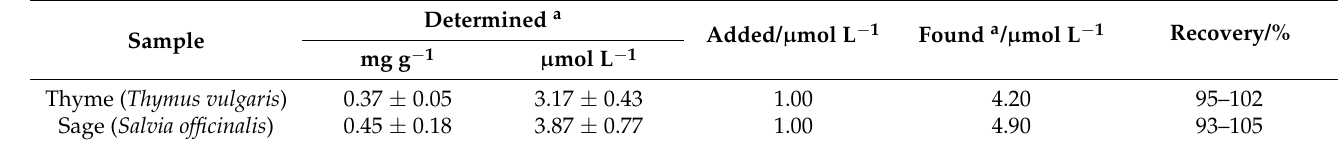
Table 2. Determination of the content of caffeic acid in thyme and sage samples using the sensor.